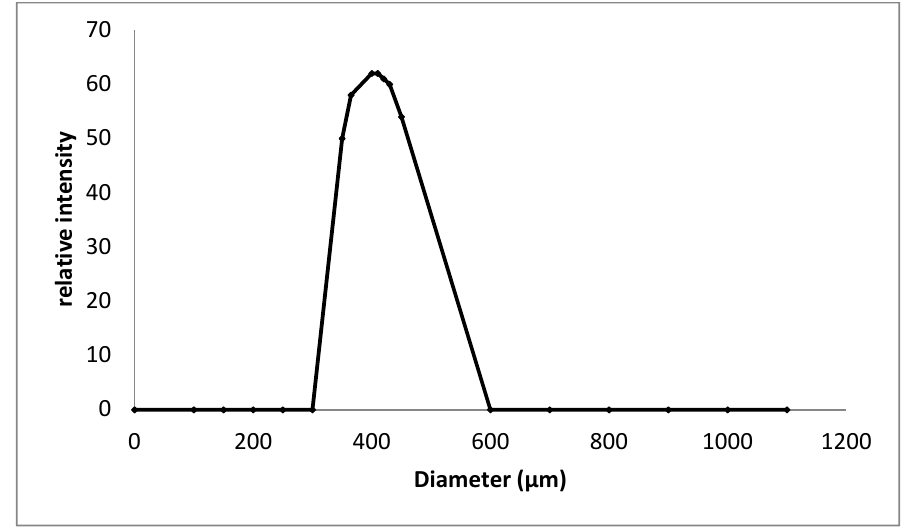
Figure 6. Size distribution curve of encapsulated